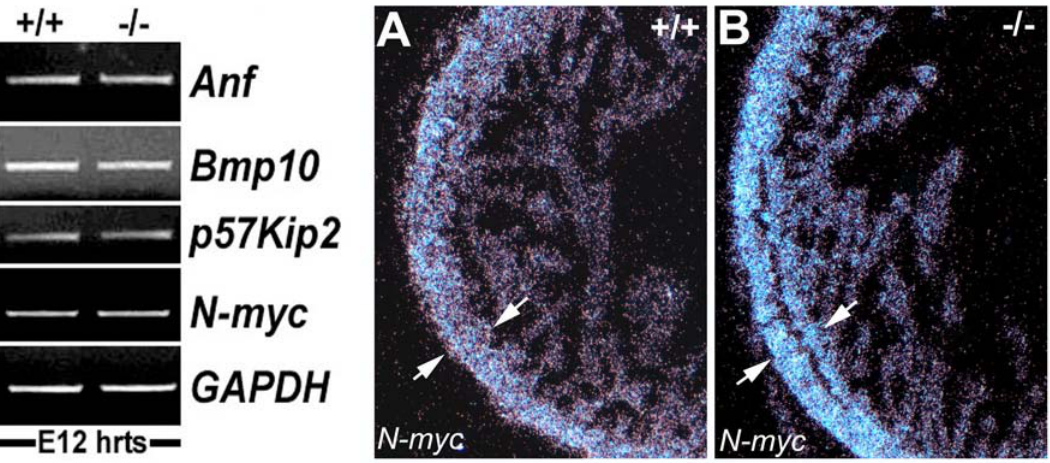
FIGURE 4. Molecular marker analysis of the E12 ventricular myocardium. (Left panel) RT-PCR analysis of trabeculae and compact layer-specific marker expression in wild-type and sp 2H mouse mutant hearts. Expression levels of the trabecular marker genes atrial natriuretic factor (Anf ), bone morphogenetic factor 10 (Bmp10 ), and p57Kip2 are unaffected in homozygous sp 2H hearts when normalized with GAPDH housekeeping gene expression. Similarly, expression of N-myc , a marker of compact myocardium, is normally expressed in mutant hearts. (Right panel) Radioactive in situ hybridization analysis of N-myc expression patterns supports the RT-PCR data and reveals that the sp 2H compact layer (B) is present and appropriately expresses N-myc in the proliferative compact myocardial layer (indicated by